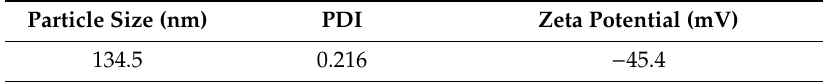
Table 1. Particle size, polydispersity index (PDI), and zeta potential of the modified pigment.